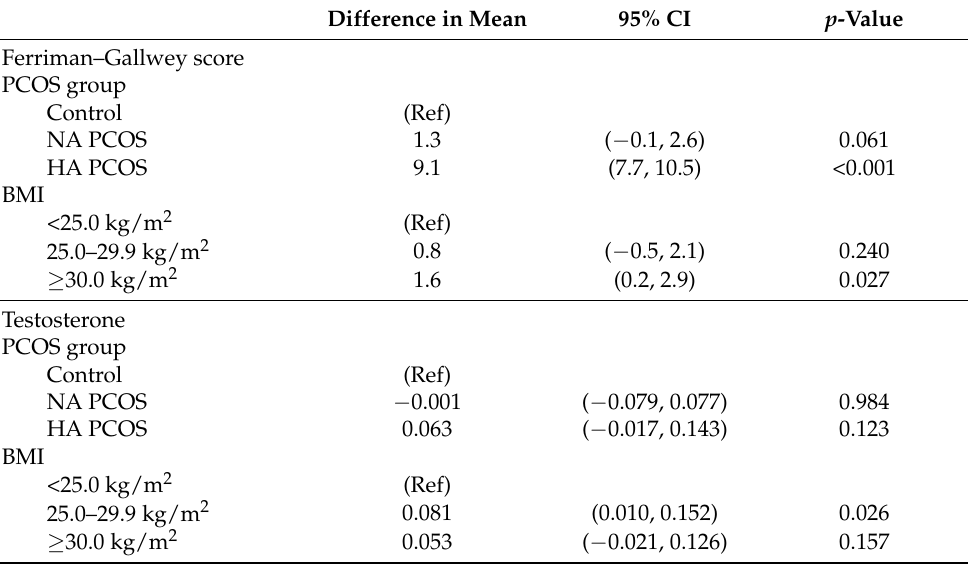
Table 3. Variables influencing hirsutism, testosterone and free androgen index in women with PCOS and controls at the follow-up assessment based on multiple regression